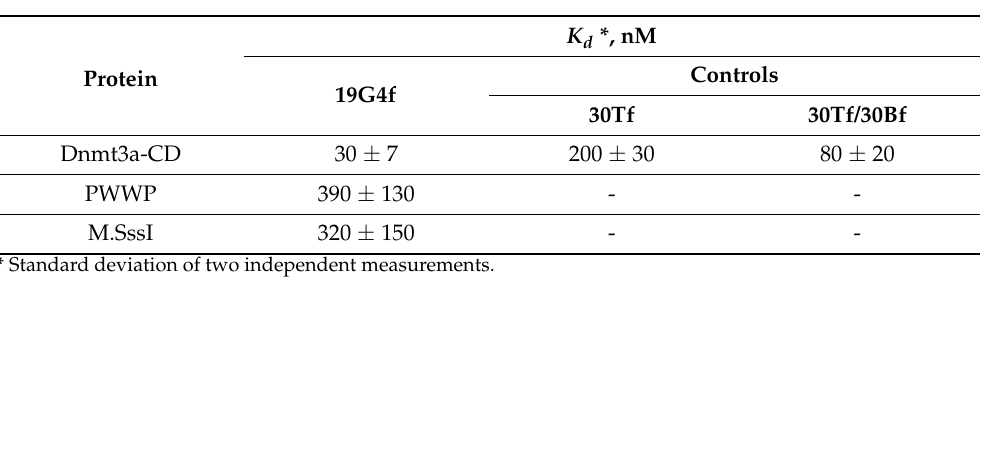
Table 1. Dissociation constants ( K d ) of 19G4f, 30Tf or 30Tf/30Bf complexes with each protein under